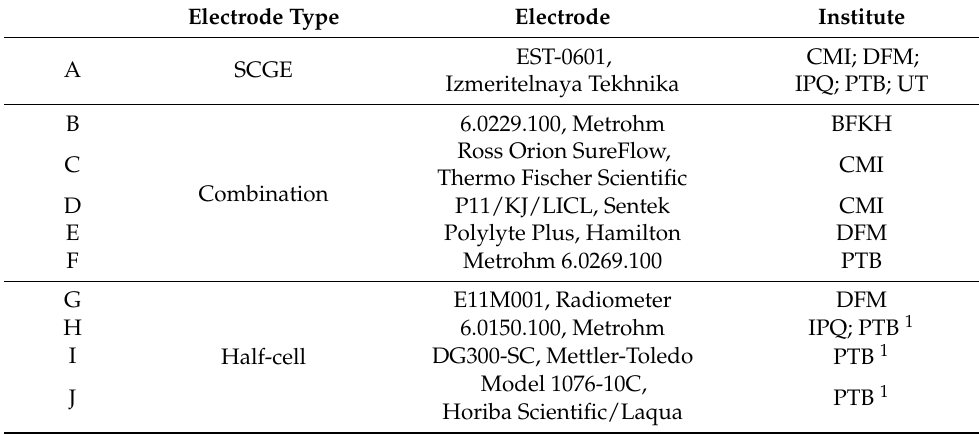
Table 1. Glass electrodes employed at each